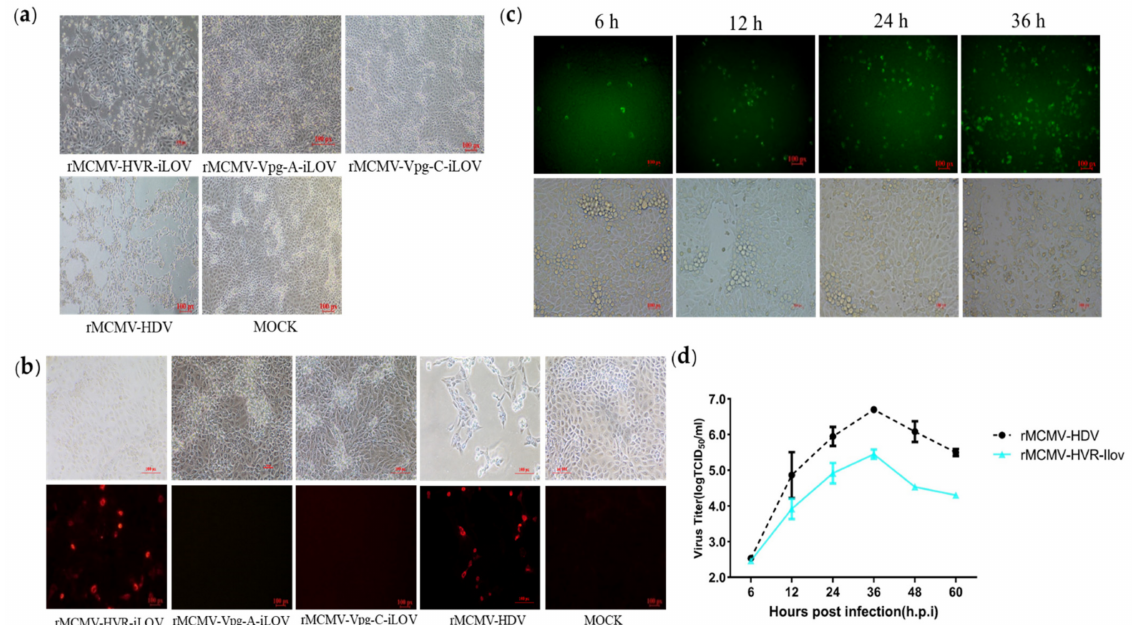
Figure 6. Characterization of a recombinant PAstV with insertion of the iLOV gene into the HVR. ( a ) Cytopathic effects were observed in PK-15 cells infected with recombinant reporter virus. ( b ) IFA analysis of the capsid protein expression in PK-15 cells. The PK-15 cells were infected with recombinant virus harboring iLOV and subjected to immunofluorescence using mouse PcAb against capsid protein. PK-15 cells were stained with goat anti-mouse IgG H&L (CoraLite594) (magnification 20 × ). ( c ) Expression of auto-fluorescent protein in cells infected with reporter virus. PK-15 cell monolayers were infected with recombinant virus harboring iLOV at a multiplicity of infection of 0.01. Green fluorescence produced from iLOV protein was directly visualized using a fluorescent microscope at 6, 12, 24, and 36 h.p.i (magnification 20 × ). ( d ) Growth curves of the recombinant reporter virus. PK-15 cells were infected with recombinant virus harboring iLOV at a multiplicity of infection of 0.01. Cell supernatants were collected at 6, 12, 24, 36, 48, and 60 h.p.i and the virus titers were determined by their TCID 50 in PK-15